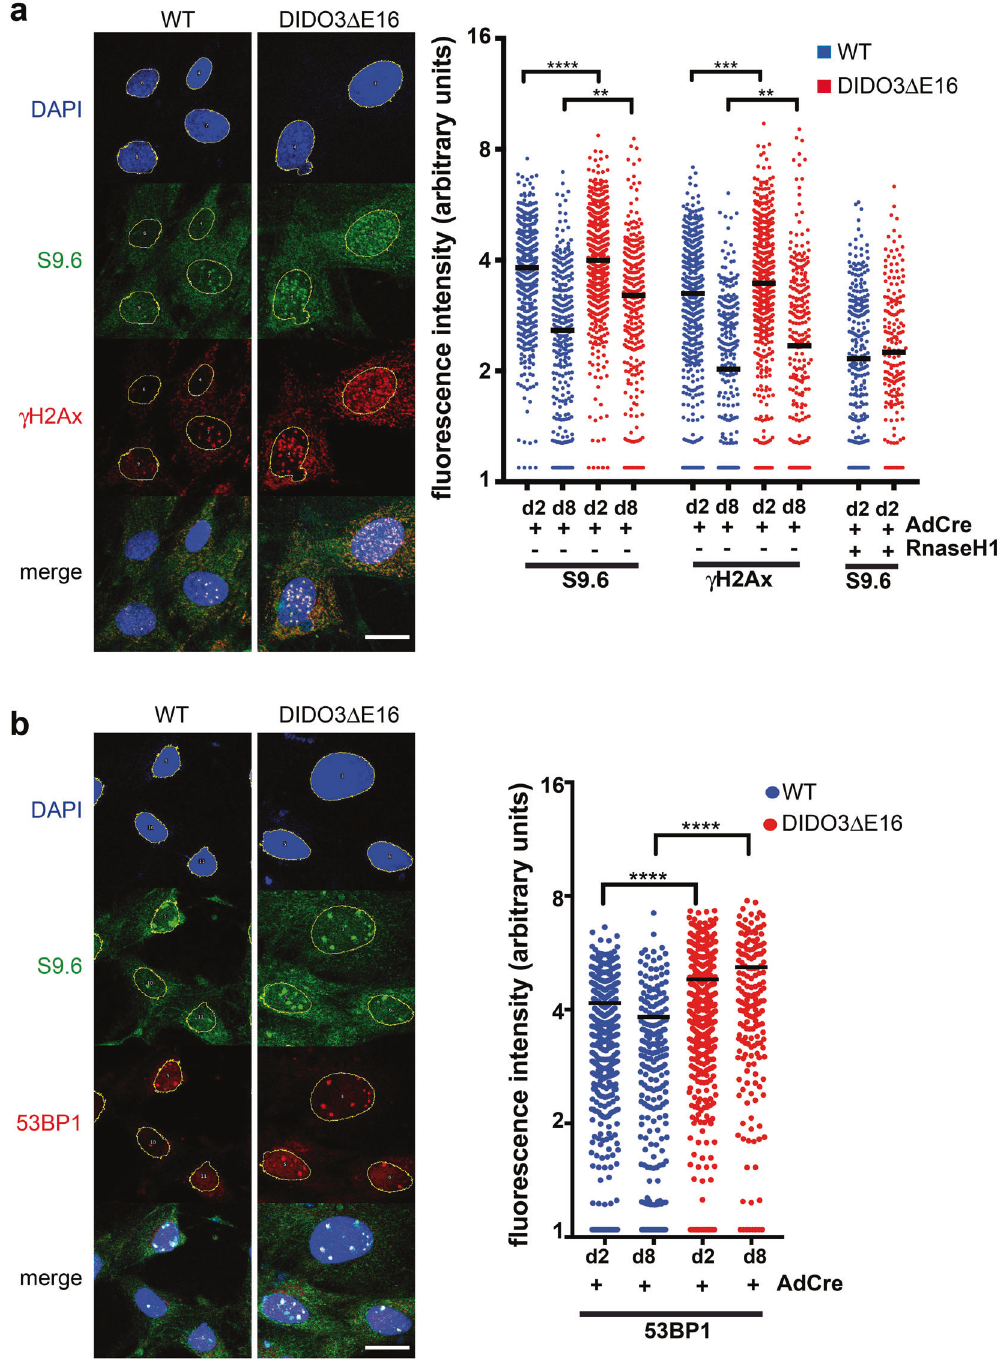
Fig. 5 R-loop levels and replication stress in DIDO3 Δ E16 MEF. a Left: Representative images of WT and DIDO3 Δ E16 MEF immuno fl uorescence after AdCre infection, using DAPI to stain nucleus (blue), S9.6 mAb to stain R-loops (green) and DNA damage- indicating antibody γ -H2Ax (red). Yellow circles depict nucleus corresponding to DAPI-positive staining and as region of interest (ROI) for ImageJ quanti fi cation of fl uorescence intensity. Bar = 25 μ m. Right: fl uorescence intensity of S9.6 mAb for R-loops and γ -H2Ax for DNA damage was quanti fi ed in the nuclear region of WT and DIDO3 Δ E16 MEF after AdCre infection at indicated times. At least 170 cells were analyzed from three different experiments. Speci fi city for S9.6 mAb was controlled after RNaseH1 treatment. Scatter dot plot with median is shown. Statistical analysis was performed with the one-way ANOVA test, **** P < 0.0001; *** P < 0.001; ** P ≤ 0.01. b Left: representative images of WT and DIDO3 Δ E16 MEF immuno fl uorescence after AdCre infection, with DAPI stain to indicate nucleus (blue), S9.6 mAb for R-loops (green), and replication stress-indicating antibody 53BP1 (red). Yellow circles depict the nucleus corresponding to DAPI-positive staining and as region of interest (ROI) for ImageJ quanti fi cation of fl uorescence intensity. Bar = 25 μ m. Right: quanti fi cation of 53BP1 fl uorescence intensity to detect replication stress in the nucleus of WT AdCre versus DIDO3 Δ E16 AdCre at d2 and d8. At least 170 cells were analyzed from three different experiments. Scatter dot plot with median is shown. Statistical analysis was performed with the one-way ANOVA test, **** P < 0.0001.